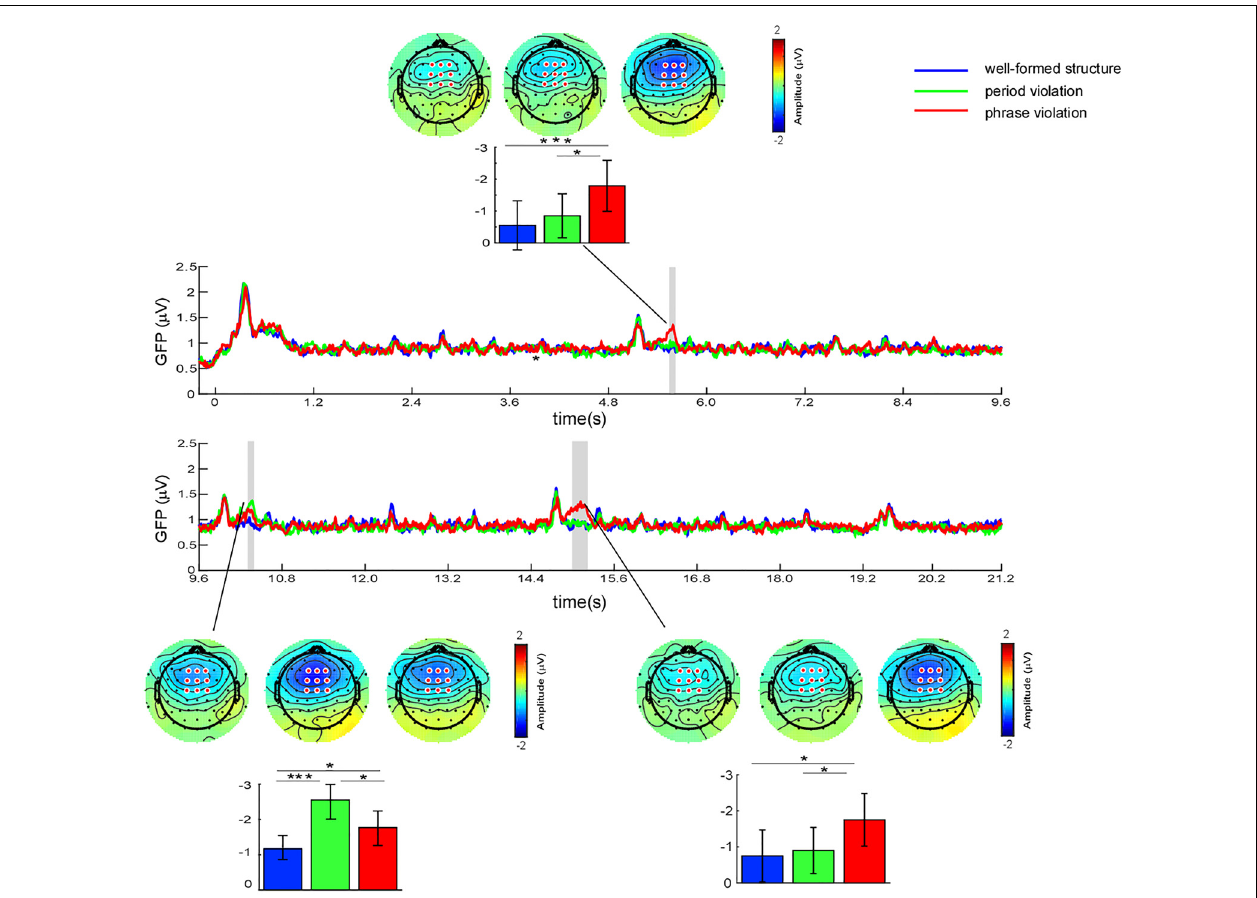
FIGURE 3 | Global field power (GFP) profiles for the three conditions over the whole musical sequences. Significant regions are marked in the gray bar [ p < 0.05, one-way analysis of variance (ANOVA) test, and false discovery rate (FDR)-corrected]. The scalp topographies were obtained around the GFP peaks for different conditions within the time window of 5,532–5,572 ms (732–772 ms after the onset of the second phrase), 10,350–10,390 ms (750–790 ms after the onset of the third phrase), and 15,132–15,172 ms (732–772 ms after the onset of the last phrase). Colored bars represent the mean of the GFP values and the amplitude of the N5 component at central-frontal electrodes for the three conditions (expressed as mean ± SD). * p < 0.05; *** p <